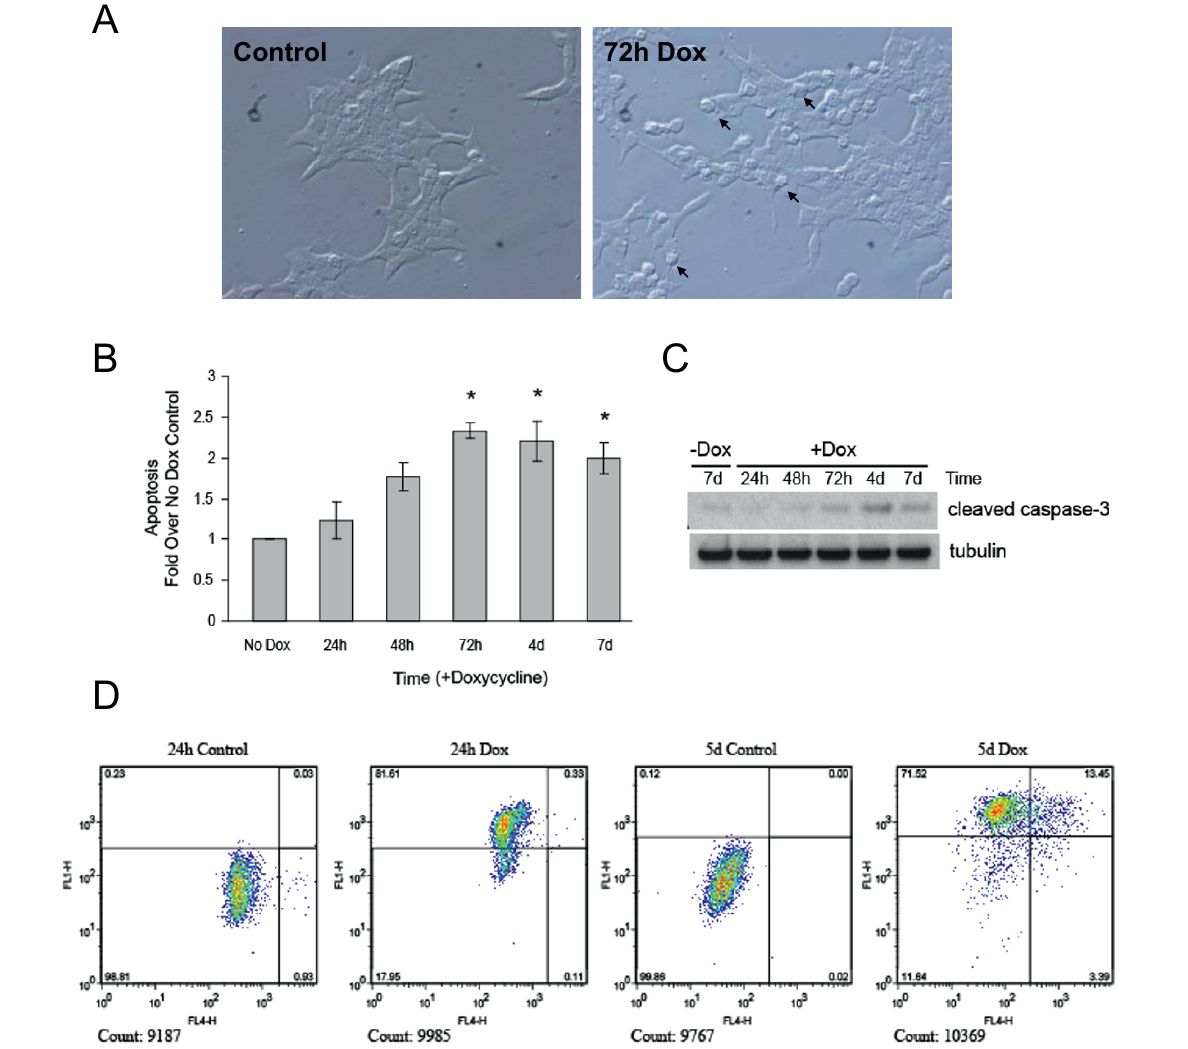
Figure 7 Expression of insulin 2 (C96Y)-EGFP induces apoptosis . A . Clone #4S2 cells were treated or not with 2 μ g/ml doxycycline for 72 h, fixed and imaged by differential interference contrast microscopy. Potentially apoptotic cells with a rounded morphology are indicated (arrows). B-D . Clone #4S2 cells were treated with 2 μ g/ml doxycycline for the indicated times. B . Following the treatments, the cells were lysed and apoptosis was measured using a cell death detection ELISA kit (Roche) as described in the methods. Shown are the mean ± SE of 4 independent experiments. *p < 0.05. C . Cells were washed in PBS, lysed and equal amounts of protein were resolved by NuPAGE and immunoblotted using antibodies to cleaved caspase-3 and g -tubulin. D . Cells were fixed and labeled with Alexa Fluor 647 dye-labeled anti-BrdU antibody. Cells were analyzed by flow cytometry; the FL1 laser excites GFP, whereas FL4 excites Fluor 647. Cells in the upper left and right quadrants were classified as mutant insulin expressing, cells in the upper and lower right quadrants were classified as apoptotic. The total number of cells examined is shown below each chart, and the percentage of cells in each quadrant is